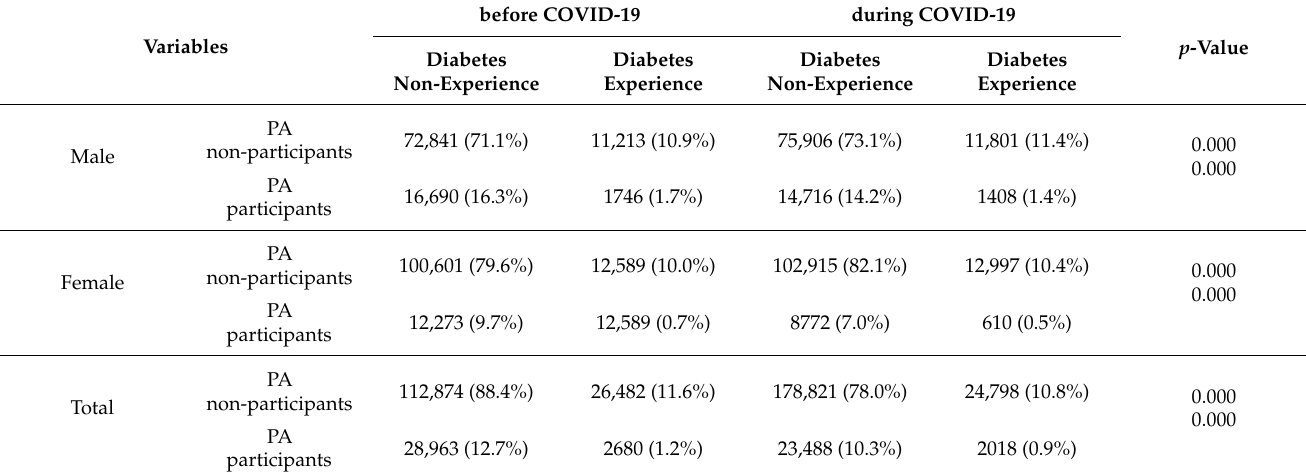
Table 5. Changes in diabetes by gender and regular PA before and during COVID-19.